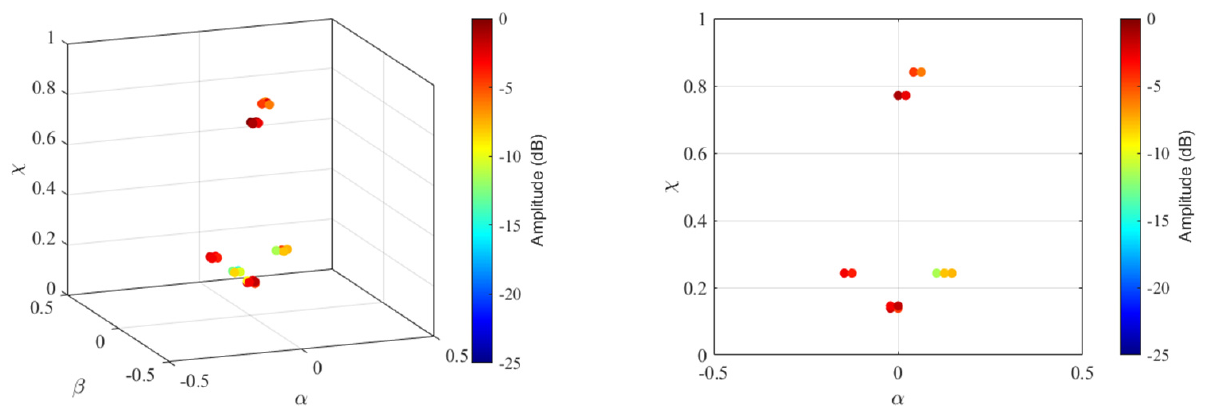
Figure 31. Real target imaging result obtained by the TSL0 algorithm.